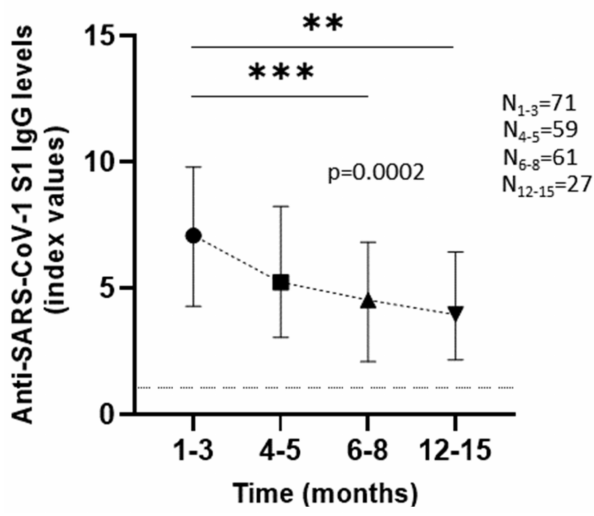
Figure 1. Anti-S1 IgGs of all patients included in the study (hospitalized or not) were measured, using Euroimmune anti-SARS-CoV-2 ELISA IgG assay, at several time-points up to fifteen months. Points at the graph represent the medians of IgG concentration at each time-point and error bars indicate the interquartile range (IQR). Horizontal dashed line represents the cut-off value of the assay used. p value indicated on the graph was calculated using Kruskal–Wallis test for all time-points collectively, while post hoc analysis of two time-points at a time also revealed statistical significance, with *** p < 0.001 and ** p <